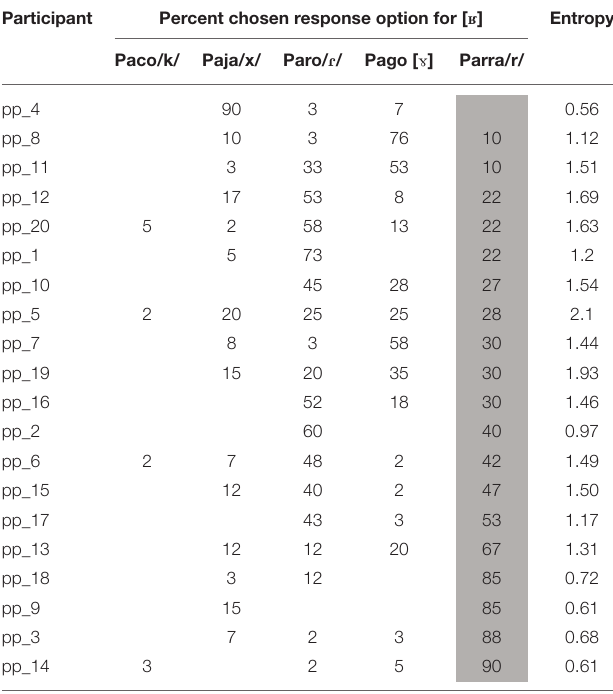
TABLE 3 | Percent chosen option for cross-language perception of the German fricative variant [ K ] per participant and each participant’s measure of entropy as a measure of consistency of